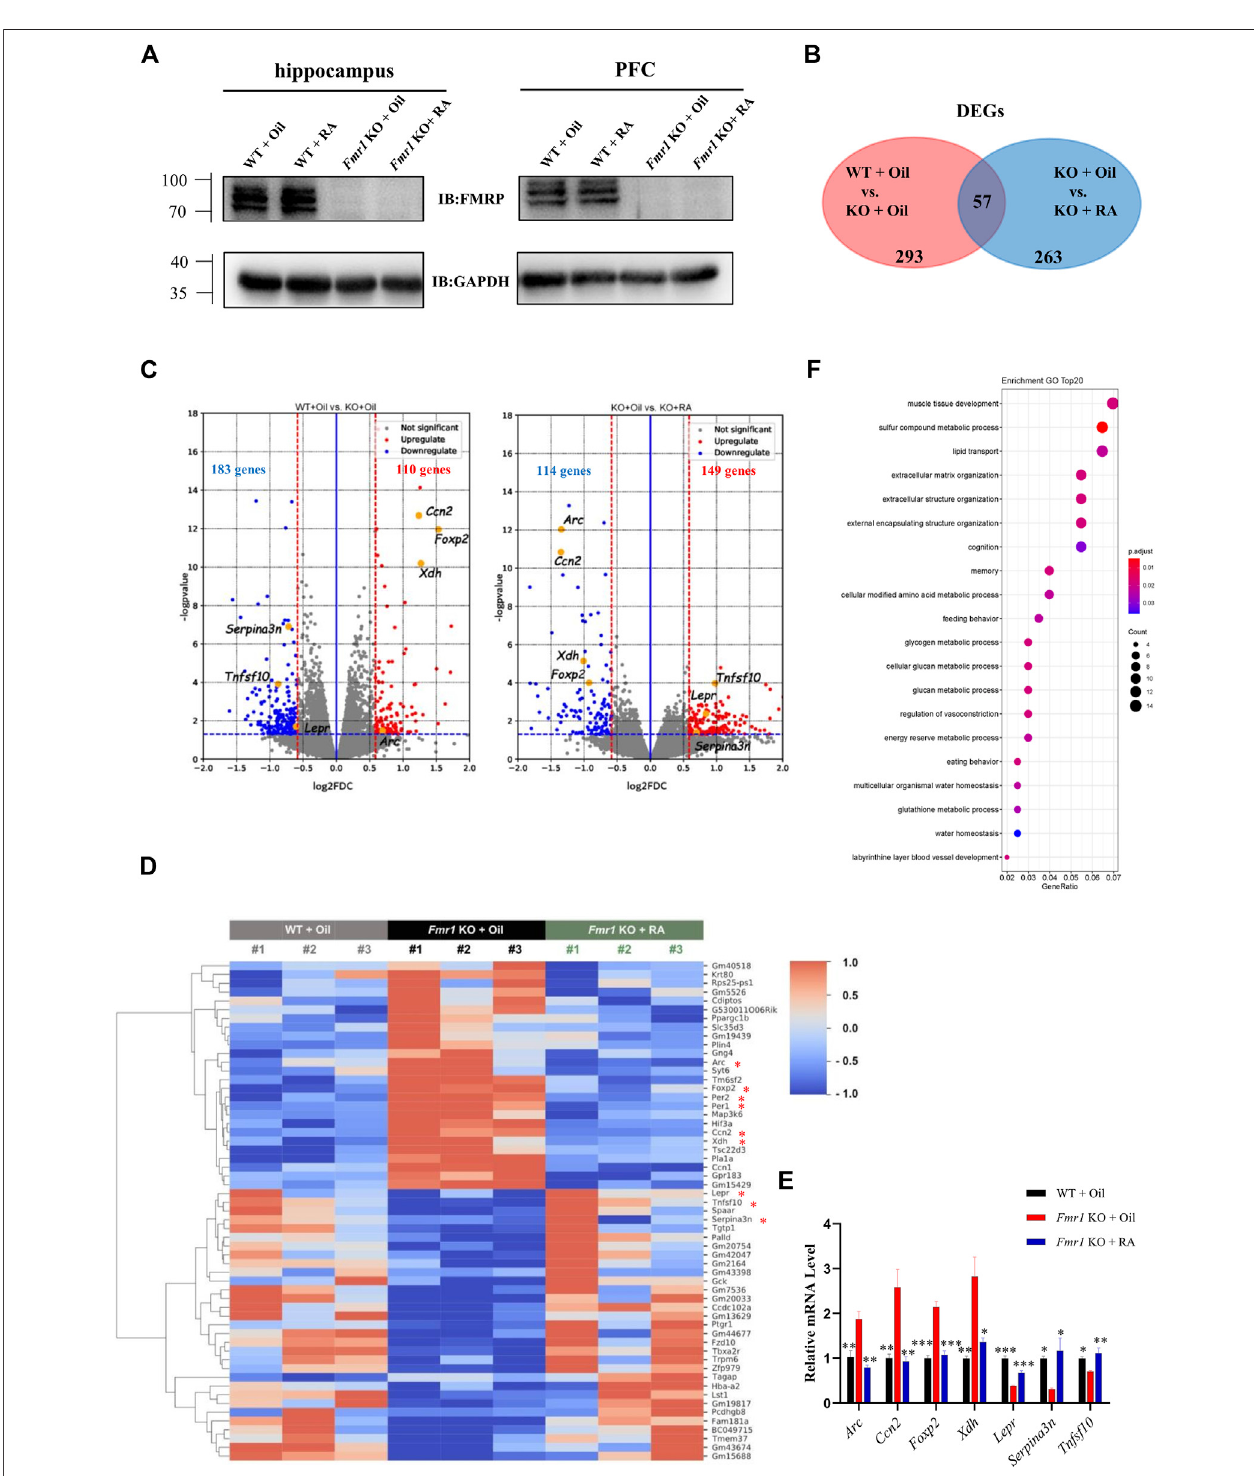
FIGURE4| RAadministrationrestoresmRNAexpressioninthePFCof Fmr1 KOmice. (A) RepresentativewesternblotsofFMRPproteinsinthehippocampusand prefrontal cortex from 4groups ofmice.(n= 3per group). (B) Venn diagram foroverlap analysis(57 genes) between differentially expressed genes(DEGs) inWT +Oil vs KO + Oil groups (293 genes) and DEGs in KO + Oil vs KO +RA groups (263 genes). (C) Volcano plots for differentially expressed genes (DEGs). Left: WT + Oil and KO + Oil groups; Right: KO + Oil and KO + RA groups. Blue dots represent down-regulated genes while red dots represent upregulated genes. The blue dashed line indicates p = 0.05. The red dashed lines indicate | FoldChange | > 1.5 ( | log2(FoldChange) | > 0.5849). (n = 3 pooled from six mice per group). (D) Heatmap represents the